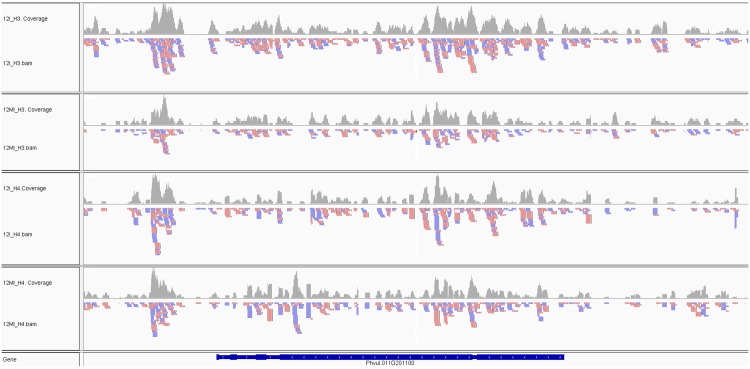
Peak signals visualized on common bean chromosomes by using Genome Viewer.Comparative visualization of a representative region on chromosome 11 in rust-inoculated common bean at 12 hai with mock-inoculated sample as background for H3K9me2 and H4K12ac modifications using Integrative Genomics Viewer (IGV).